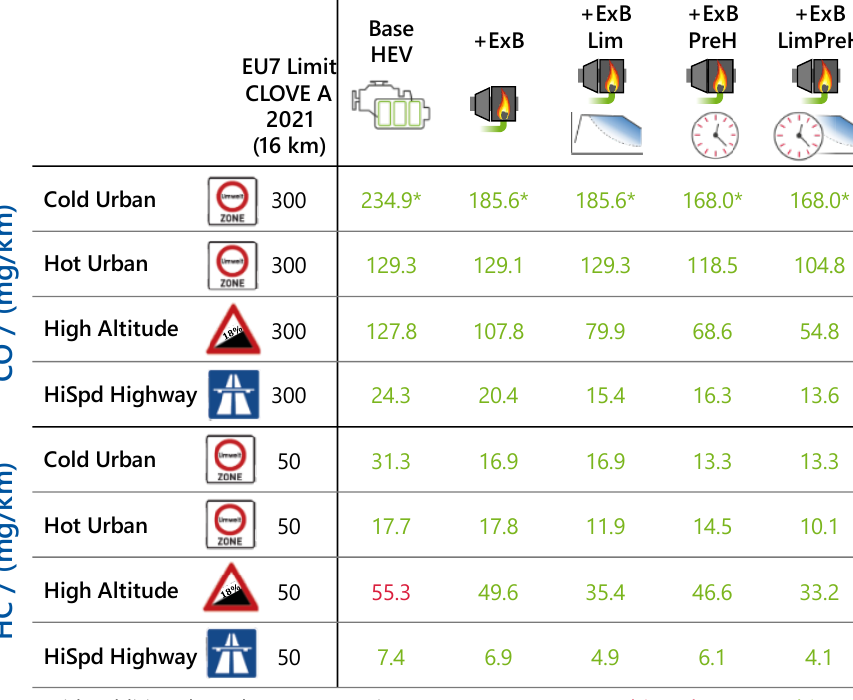
Figure A2. Exhaust burner technology results for CO and HC in the Euro 7